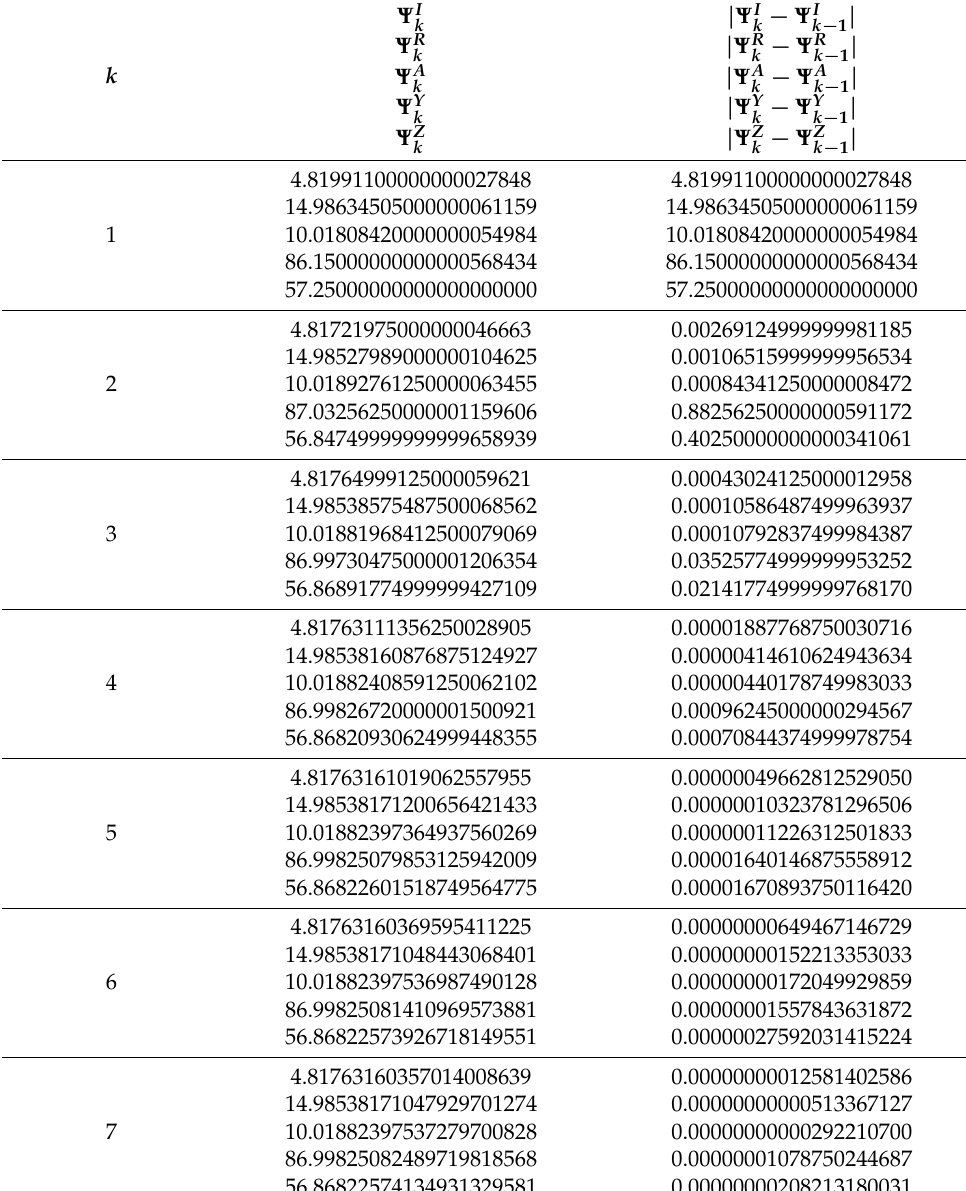
Figure 4. Graph of residual error functions based on t for ¯ h = − 1 and k = 5,10. Table 2. The numerical results based on the FPA for t = 0.5, ρ = 1, ¯ h = − 1 and ε = 10 − 10